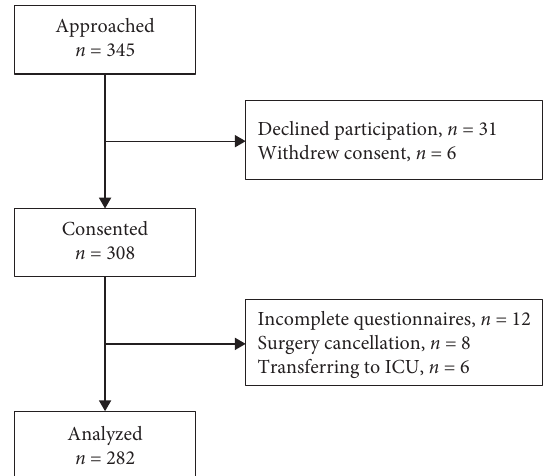
Figure 1: Flowchart of the study. ICU: intensive care